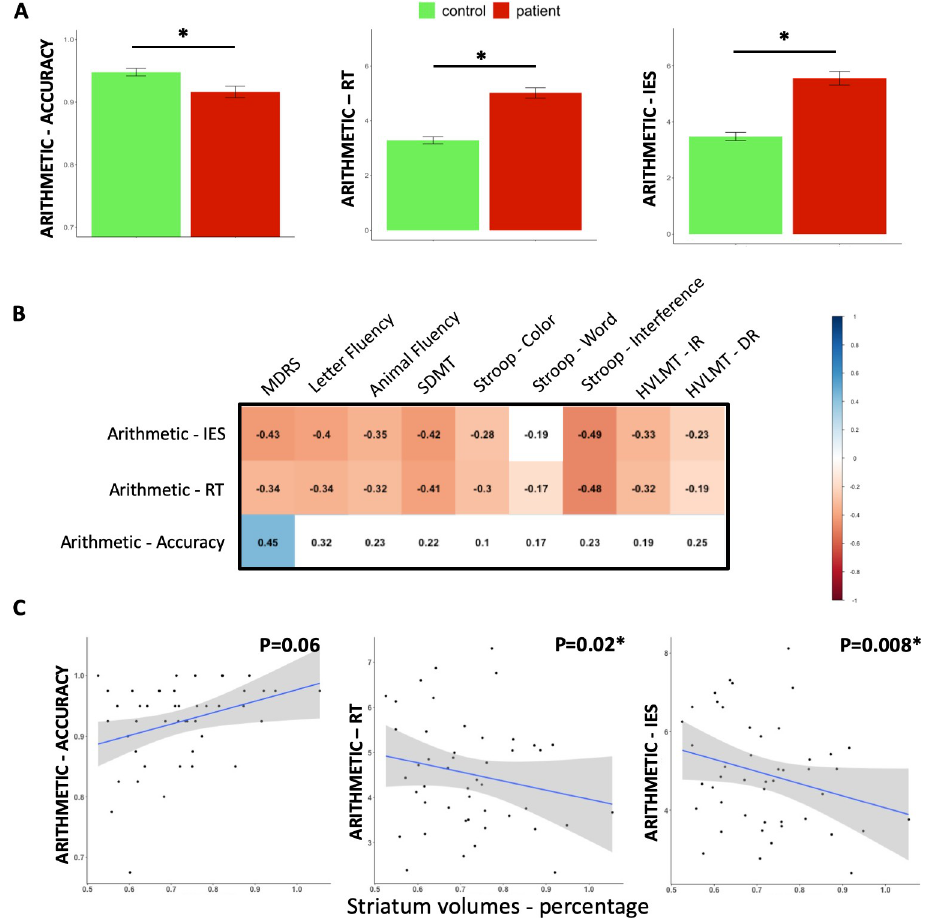
Fig 2. Baseline results. A–Discriminant validity at baseline: significant differences between groups are represented by a star (p < 0.05). B—Pearson correlations between arithmetic scores and cognitive measures (Bonferroni correction, p- values � 8) in HD patients. Blue colour indicates significant positive correlations and red colour significant negative correlation. White colour indicates non-significant correlation. C–Association between striatal volumes and accuracy, response time and IES in the arithmetic task (across the two operations) in HD patients. MDRS Mattis Dementia Rating Scale, SDMT symbol digit modalities test, HVLT Hopkins Verbal Memory Test, IR immediate recall, DR delayed recall.